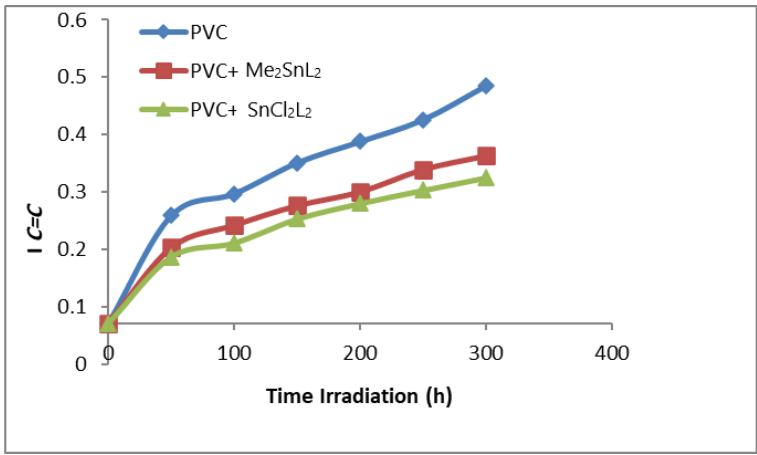
Figure 4. Changes in the I C=C index for PVC films versus irradiation time.